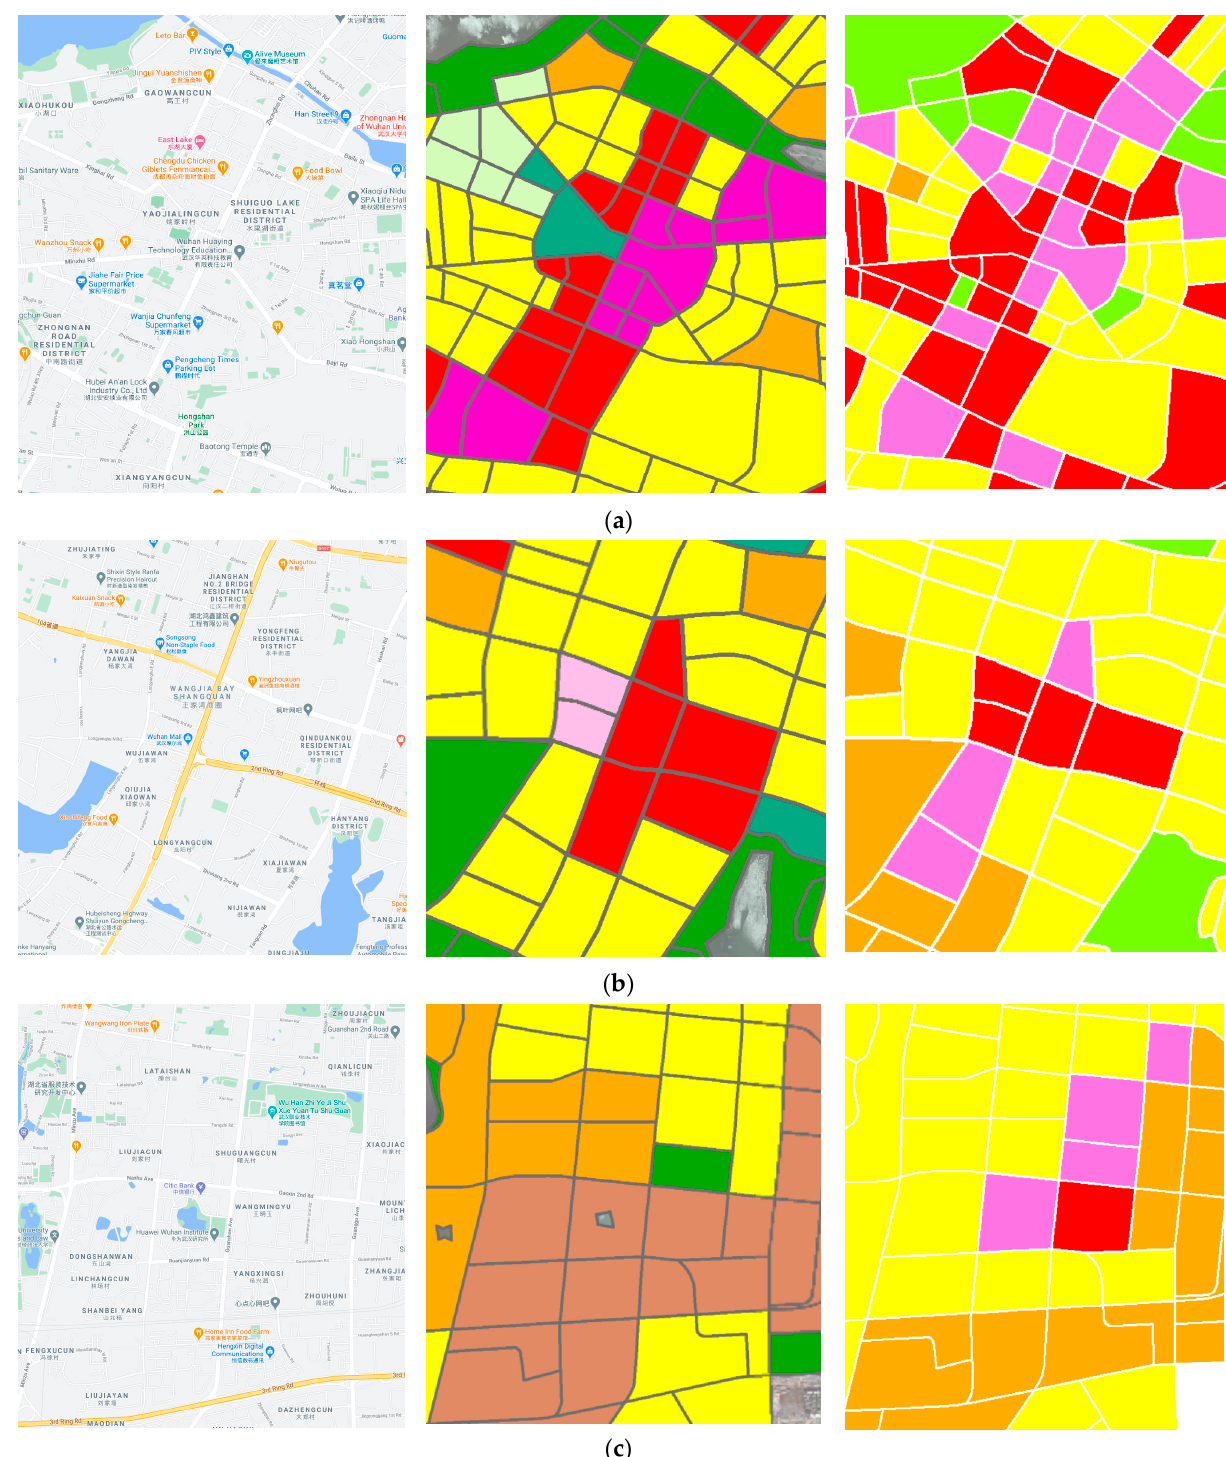
Figure 11. Comparison of local regions classification results. ( a ) The central area in Wuchang; ( b ) the central area in Hanyang; ( c ) the area southeast of Wuchang (The Google online maps are on the left; the planning maps are in the middle and our classification results are on the right).